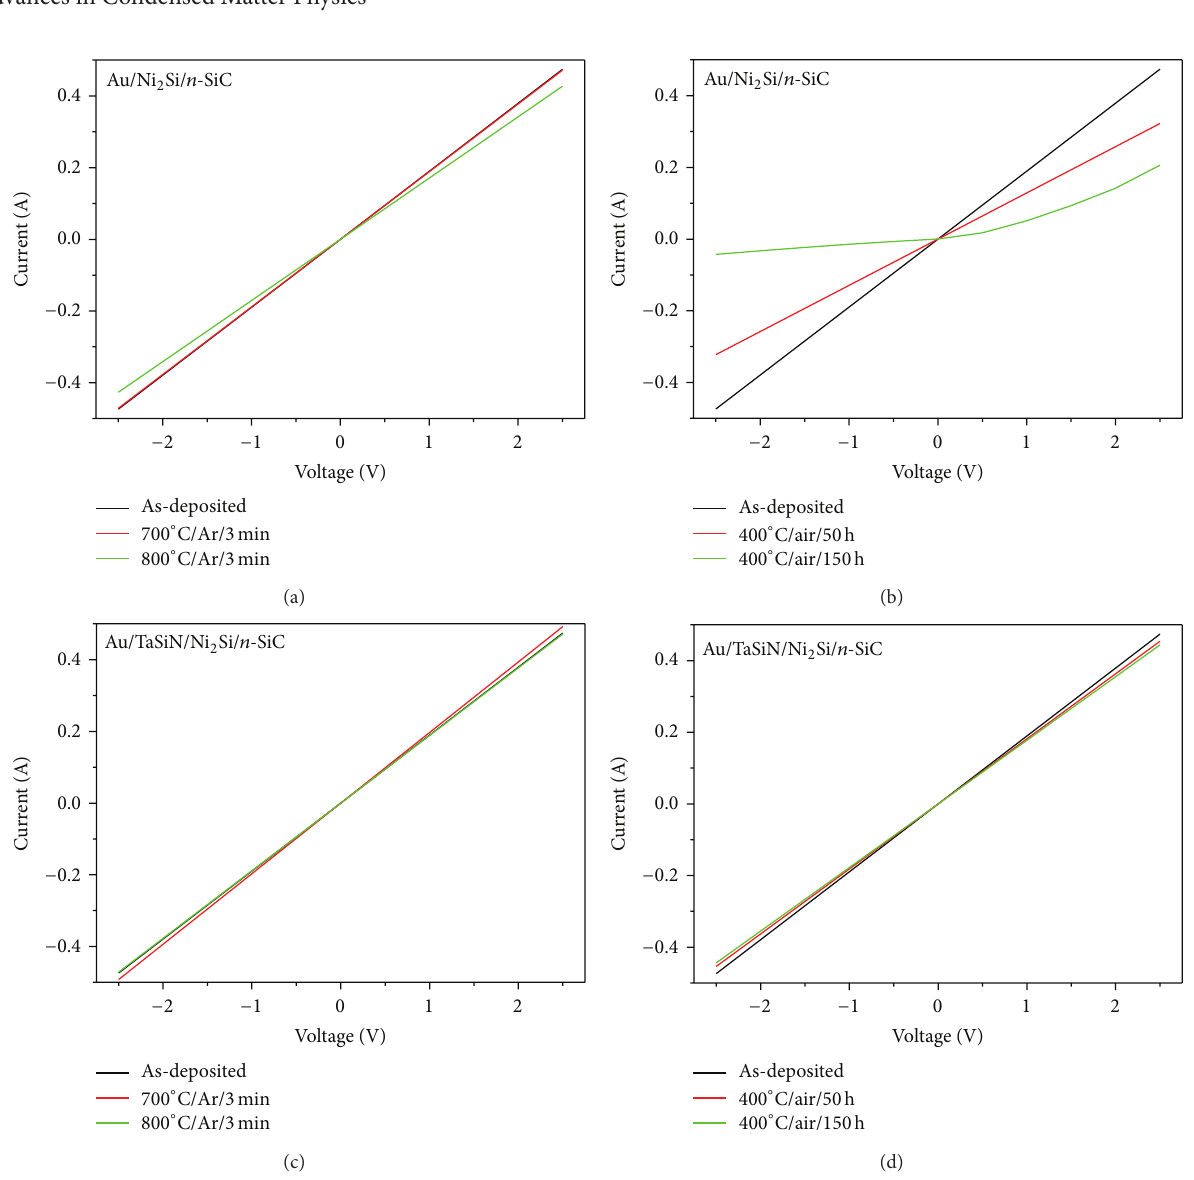
Figure 15: Current-voltage characteristics for the Au/Ni 2 Si/ n -SiC (a, b) and Au/Ta 35 Si 15 N 50 /Ni 2 Si/ n -SiC (c, d) ohmic contacts versus heat